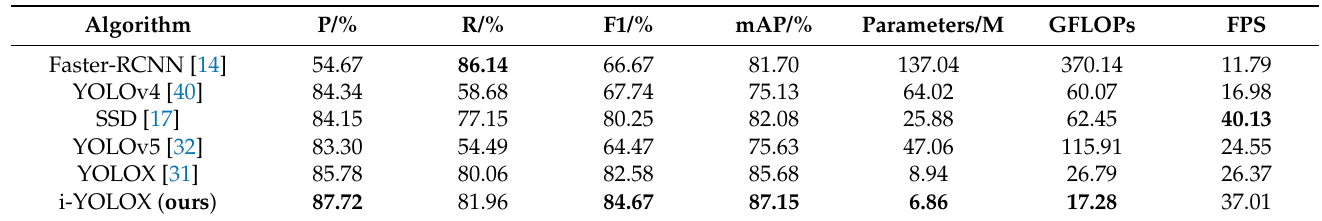
Table 5. Comparison with other algorithms. The bolded parameters are the most